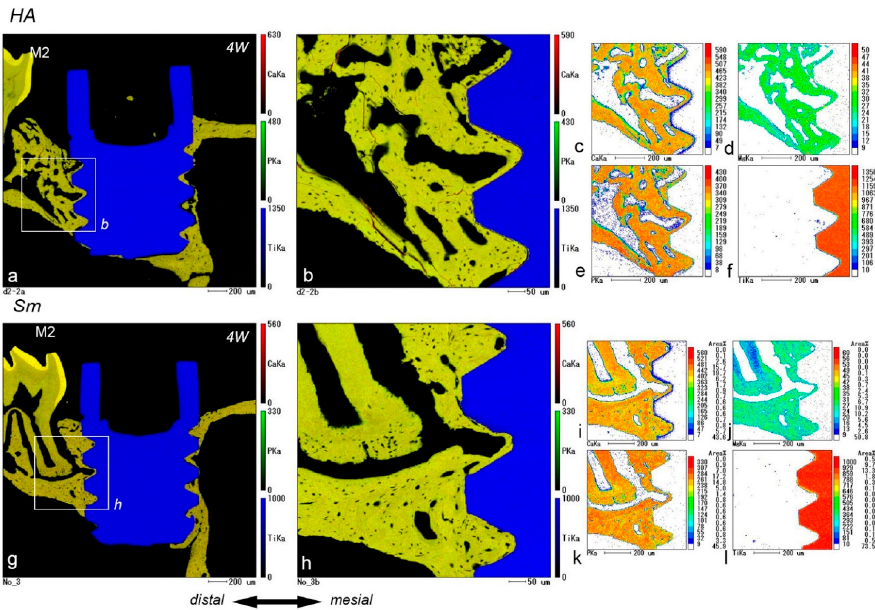
Figure 5. Sagittal views of the tissues surrounding the implants in the HA ( a – f ) and Sm groups ( g – l ) at week 4 after implantation obtained by EPMA procedures. ( b ) and ( h ) are higher magnifications of the boxed areas in ( a ) and ( g ), respectively. ( a , b , g , h ) Direct contact between the implant surface and surrounding bone is completed, although certain areas are not covered with bone. ( c – f , i – l ) The calcium ( c , l ), phosphorus ( e , k ), and magnesium concentrations ( d , j ) in the surrounding bone do not appear to be different from those of the preexisting bone. Low calcium levels are observed on the surface of the implant ( f , l ). IS, implant space. Scale bars = ( a , c – g , i – l ) 200 μ m, and ( b , h ) 50 μ m.